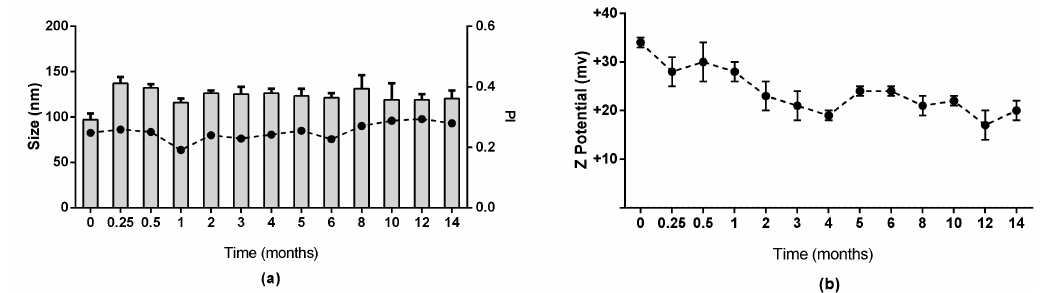
Figure 3. Stability of chitosan nanocapsules during storage at 4 ◦ C for 14 months. ( a ) = size and polydispersity index (PI) ( b ) = zeta potential (mean ± SD, n =